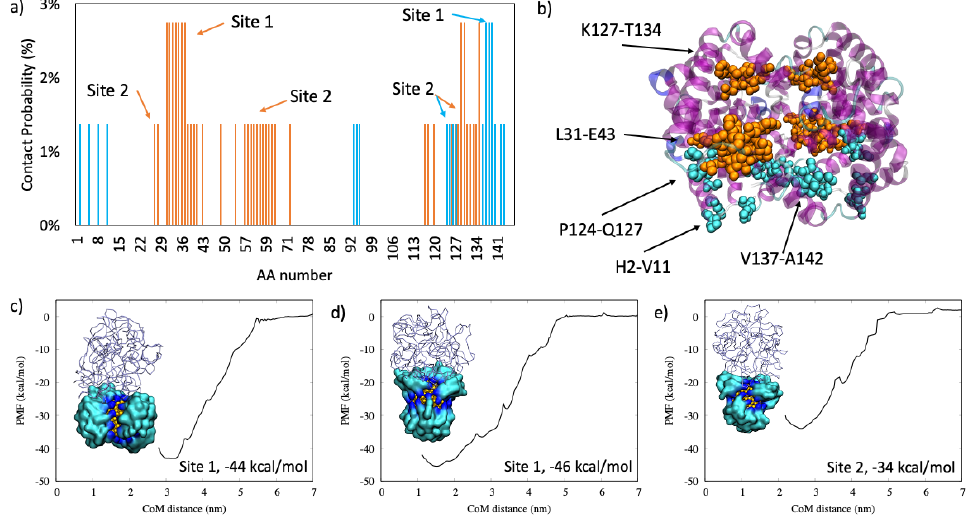
Figure 4. In panel ( a ): the contact probability for each residue upon hemoglobin binding to all-MUS AuNP. In panel ( b ): the graphical representation of the most probable binding sites in VdW, colored according to the different hemoglobin chains: chain A is in orange, and chain b is in cyan. In panels ( c – e ): the two binding modalities with the relative PMF curve.